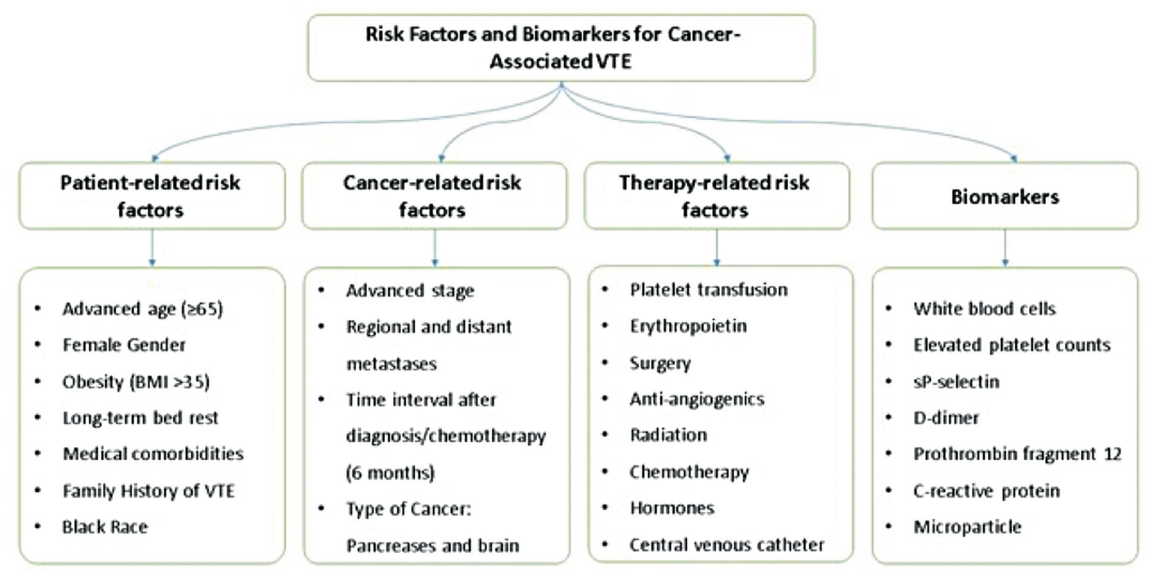
Fig. 1 Risk factors of cancer-associated thrombosis